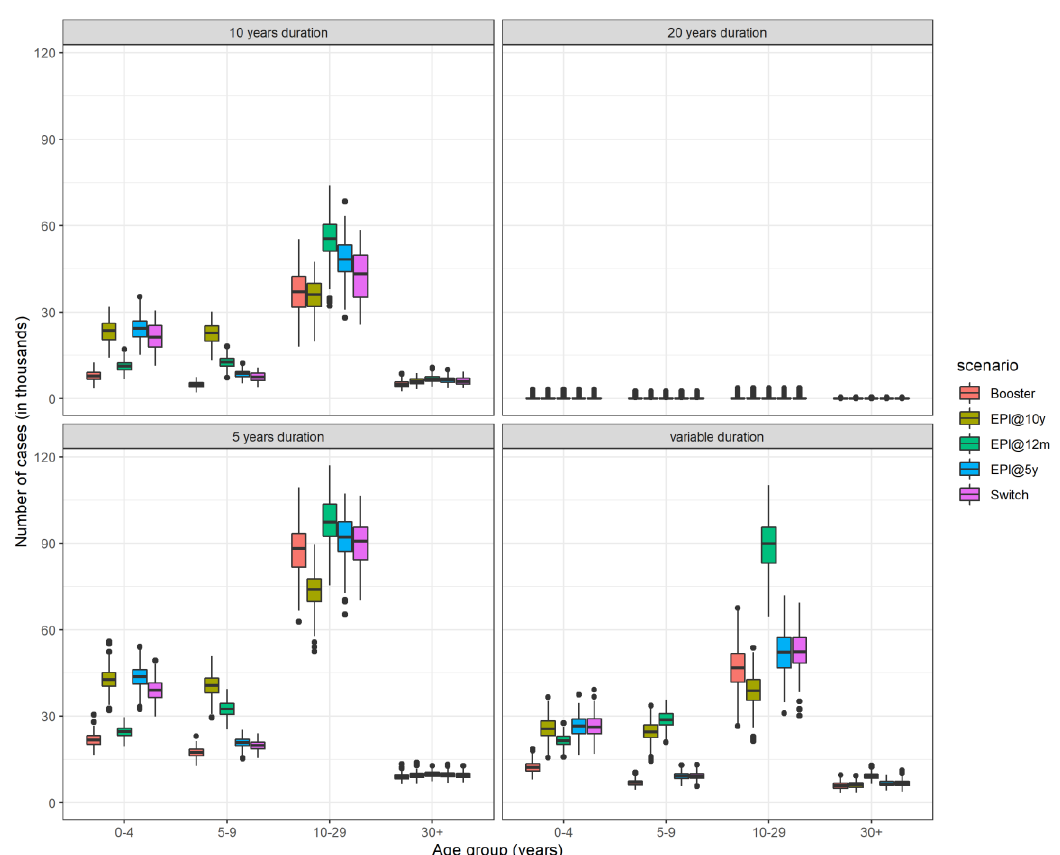
Figure 4. Box plot showing the median, interquartile range, and full range of the total number of cases by age group from 200 simulation runs aggregated over the time period 2010–2060.